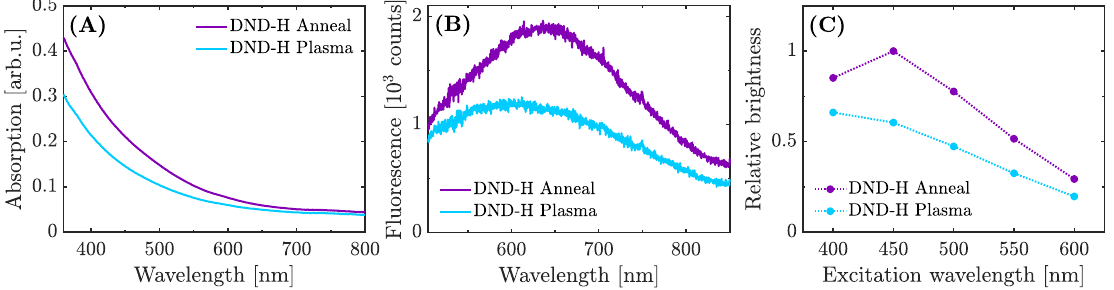
Figure 4. Optical properties of hydrogenated DND particles suspended in water (0.4 mg mL − 1 ). ( A ) Absorption spectra; ( B ) fluorescence spectra for 450 nm excitation wavelength λ ex ; ( C ) fluorescence brightness (integrated between 660 and 800 nm for each λ ex , detailed in SI) as a function of excitation wavelengths ranging from 400 to 600 nm.